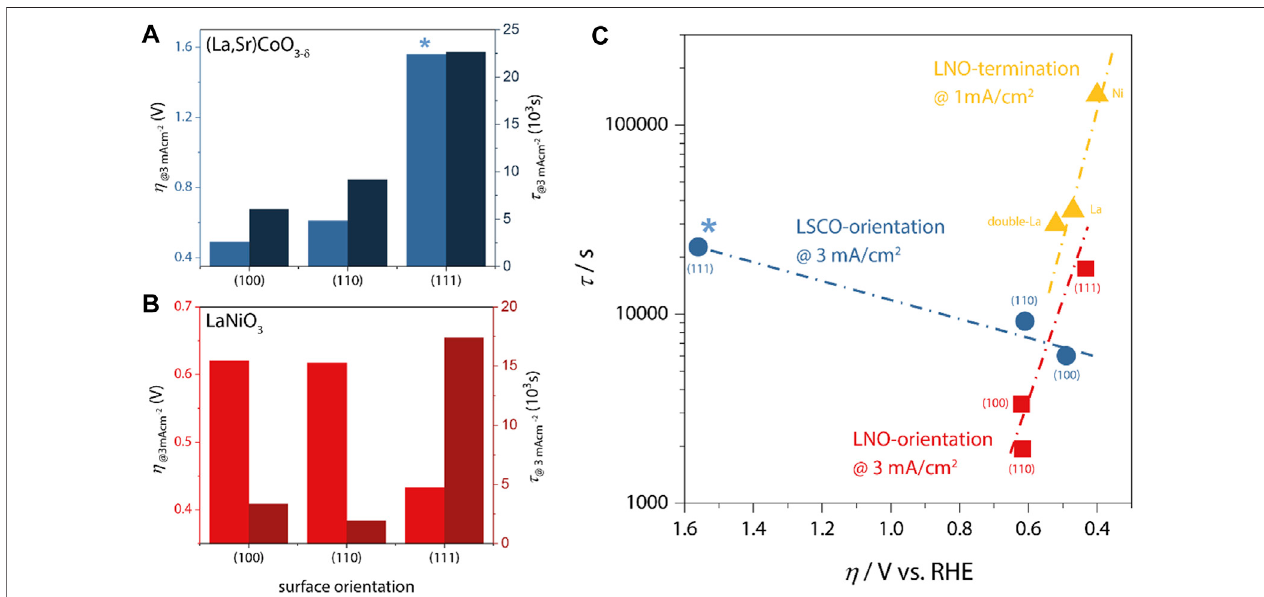
FIGURE2|(A,B) Overpotential(left axes)and catalystlifetime (rightaxes)at aloadcurrentdensity of3 mA/cm 2 forLSCOand LNO,respectively. *noIR-correction wasapplied for(111) LSCObecauseimpedancespectrawereinconclusive.ThesamequalitativetrendsareobservedwithandwithoutIR-correction for allsamples. (C) Lifetime vs. overpotential asafunction ofLSCO and LNO orientation(blue and red data, respectively) and LNO-termination [yellow; comparison ofNiO 2 -termination (Ni), LaO-termination (La) and LaO-double-layer-termination (double-La)]. Note that termination-dependent measurements were performed at lower current density, which generally leads to higher lifetimes. Nevertheless, the same departure from inverse activity-stability trends is apparent for all LNO data.